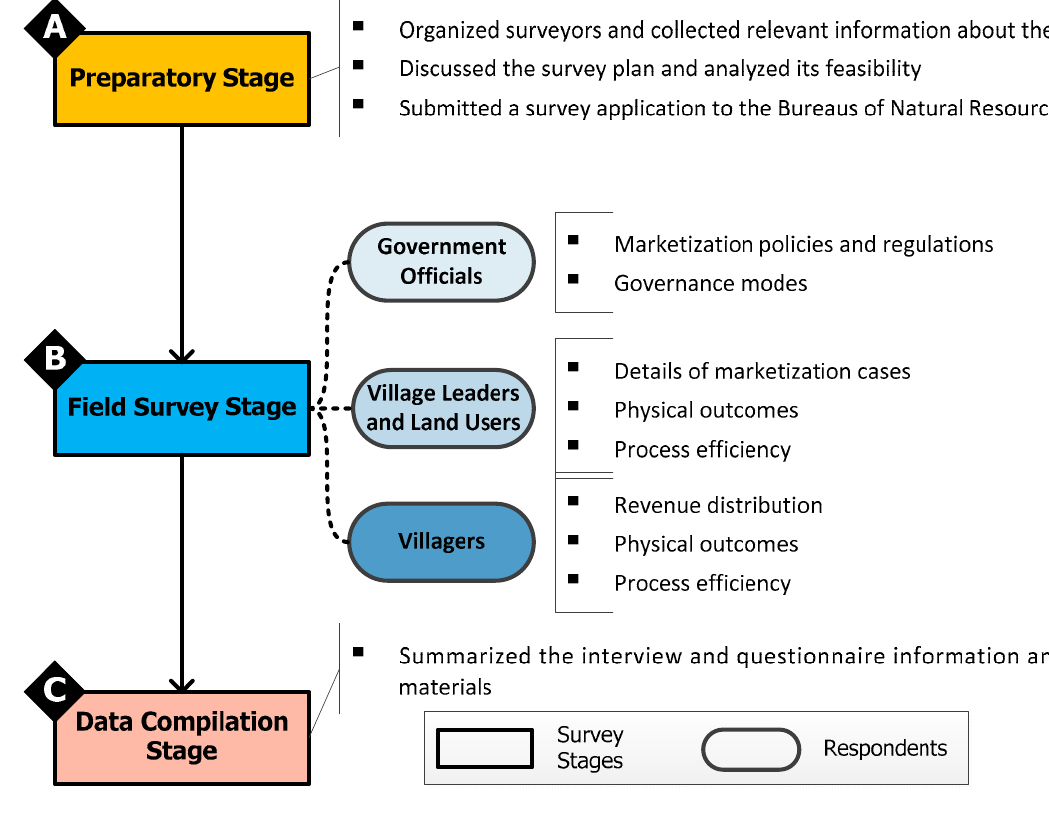
Figure 3. The survey scheme.